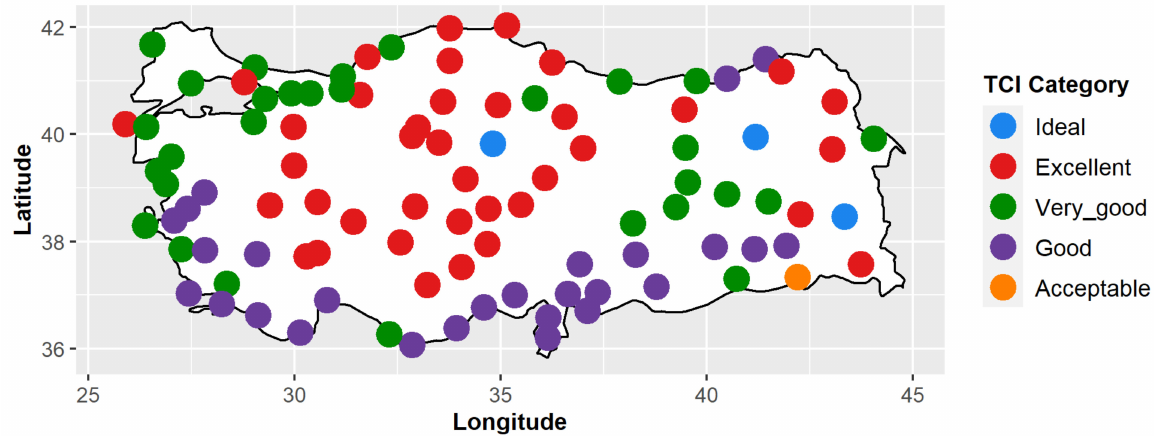
Figure A7. TCI distribution for June.